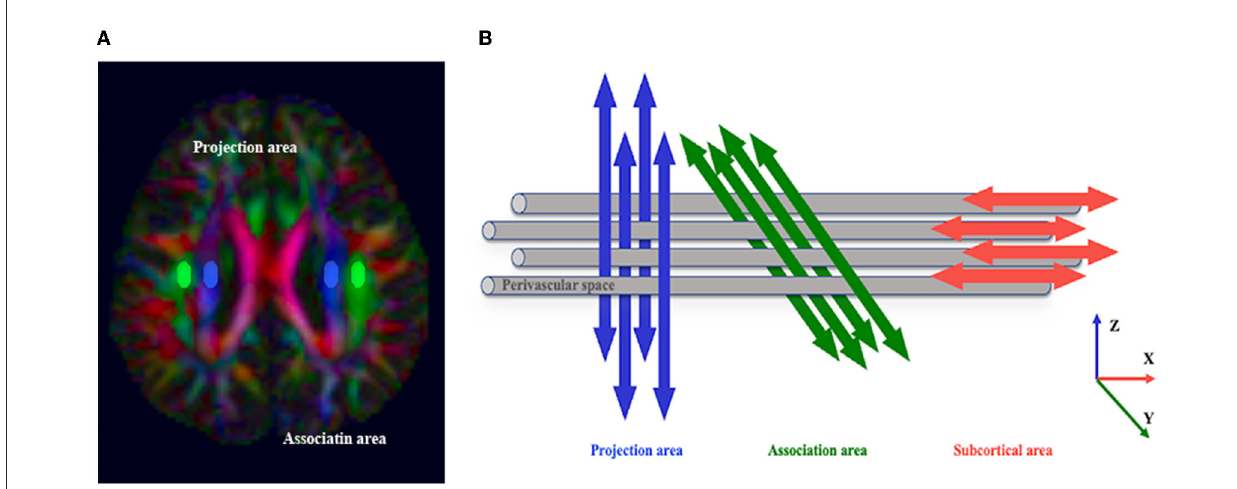
FIGURE3 The concept of the diffusion tensor image analysis along the perivascular space (DTI-ALPS) method. (A) The DTI color map shows the direction of the projection fibers ( z -axis, blue), association fibers ( y -axis, green), and subcortical fibers ( x -axis, red). Two regions of interest (ROIs) are placed to measure the diffusivities of the projection (projection area) and association (association area) fibers. (B) The schematic diagram indicates the relationship between the direction of the perivascular space (gray cylinder) and the direction of the fibers. Note that the direction of the perivascular space is perpendicular to the projection and association fibers (Taoka et al.,